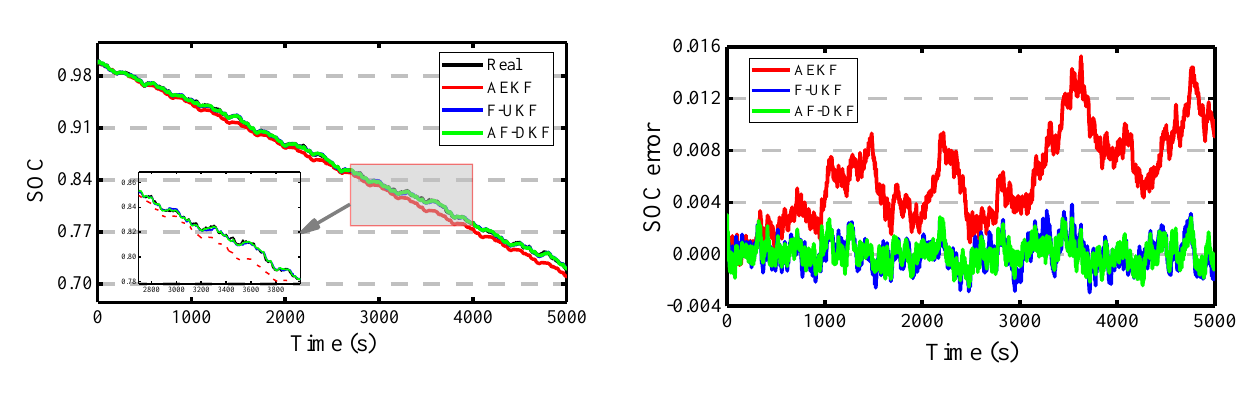
( d ) Estimated error comparison Figure 8. The BBDST experiment index Figure 8. The BBDST experiment index curves.